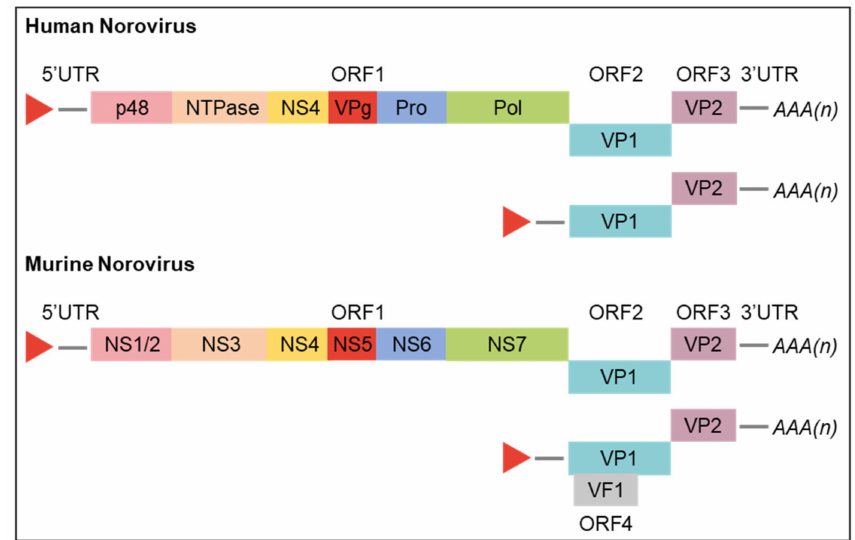
Figure 2. Schematic diagram showing the organisation of norovirus genomes. ( Above ) The human norovirus genome is covalently attached to genome-linked viral protein VPg at the 5 (cid:48) end and is polyadenlyated at the 3 (cid:48) end. The genome is divided into three open reading frames (ORFs). ORF1 is translated as a polyprotein, which is cleaved by the viral protease (Pro) to produce the nonstructural proteins (p48, NTPase, p22, VPg, Pro, and Pol). ORF2 and ORF3 are translated from a subgenomic RNA. They encode the major structural protein, VP1, and the minor structural protein, VP2, respectively. The 5 (cid:48) and 3 (cid:48) genome extremities contain short untranslated regions (UTRs). ( Below ) The murine norovirus shares a similar genome organisation but has an additional fourth ORF, which overlaps with ORF2 and is also translated primarily from subgenomic RNA into the virulence factor 1 (VF1) protein; adapted from Thorne and Goodfellow 2014